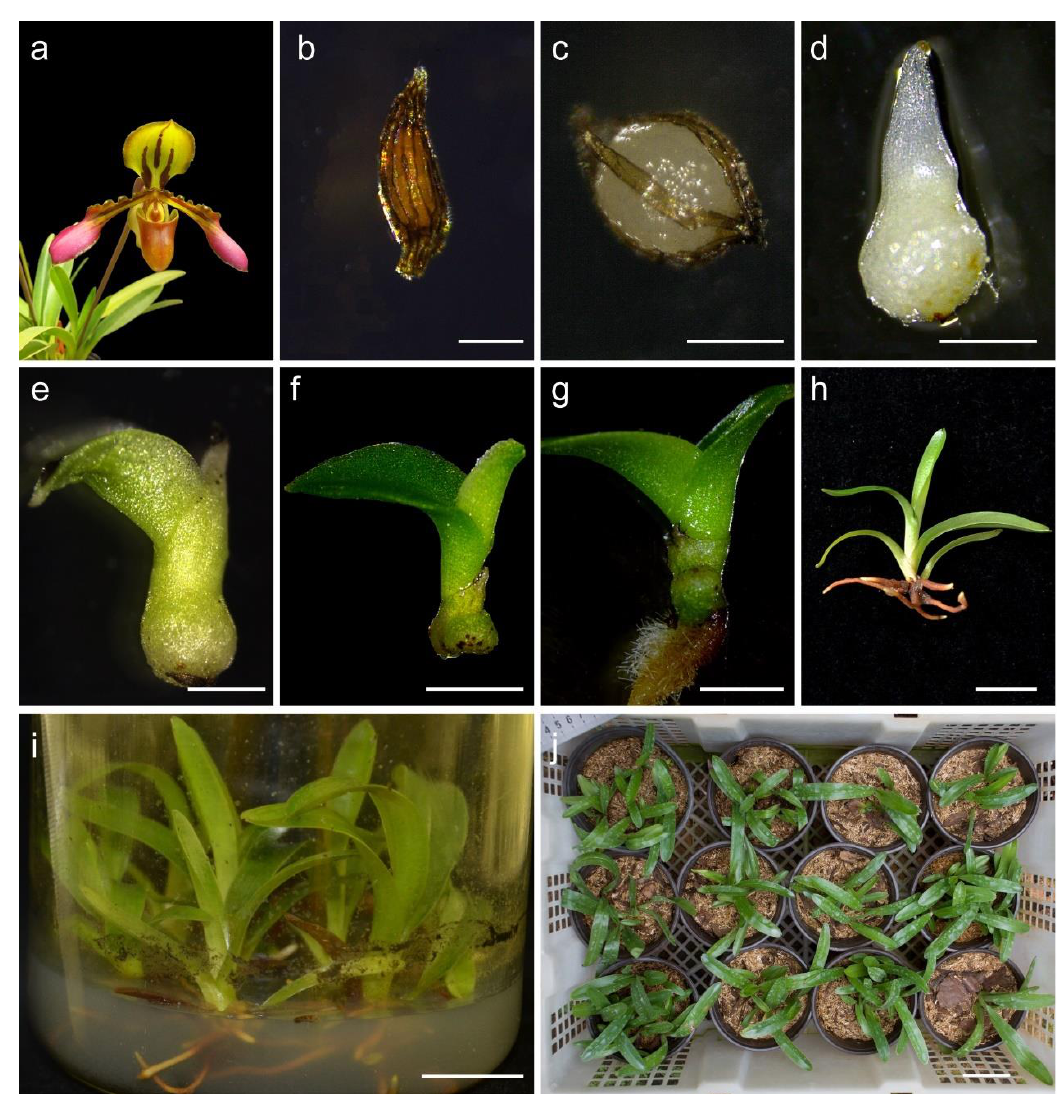
Figure 1. In vitro seed germination of Paphiopedilum tigrinum . ( a ) Flowering plants of P. tigrinum ; ( b ) a mature seed with dark brown and opaque seed coat; ( c ) testa ruptured; ( d ) appearance of the shoot and rhizoids; ( e ) emergence and elongation of the first leaf; ( f , g ) presence of the second leaf and roots; ( h , i ) seedlings with green leaves and roots cultured on the 1/2 MS medium containing 0.5 g·L −1 dolomite flour, 1.0 g·L −1 activated charcoal, 15 g·L −1 potato homogenate and 30 g·L −1 banana homogenate for 6 months; ( j ) seedlings maintained in the greenhouse for three months. Bar: ( b , c ) 500 μm; ( d – g ) 2 mm; ( h – j ) 4 cm.